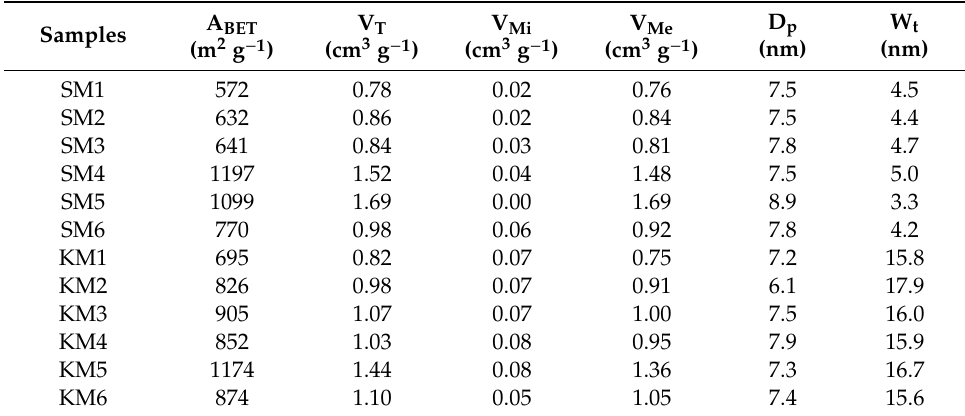
Table 4. Physical properties of SBA-15 and KIT-6 Table 4 . Physical properties of SBA-15 and KIT-6 samples.